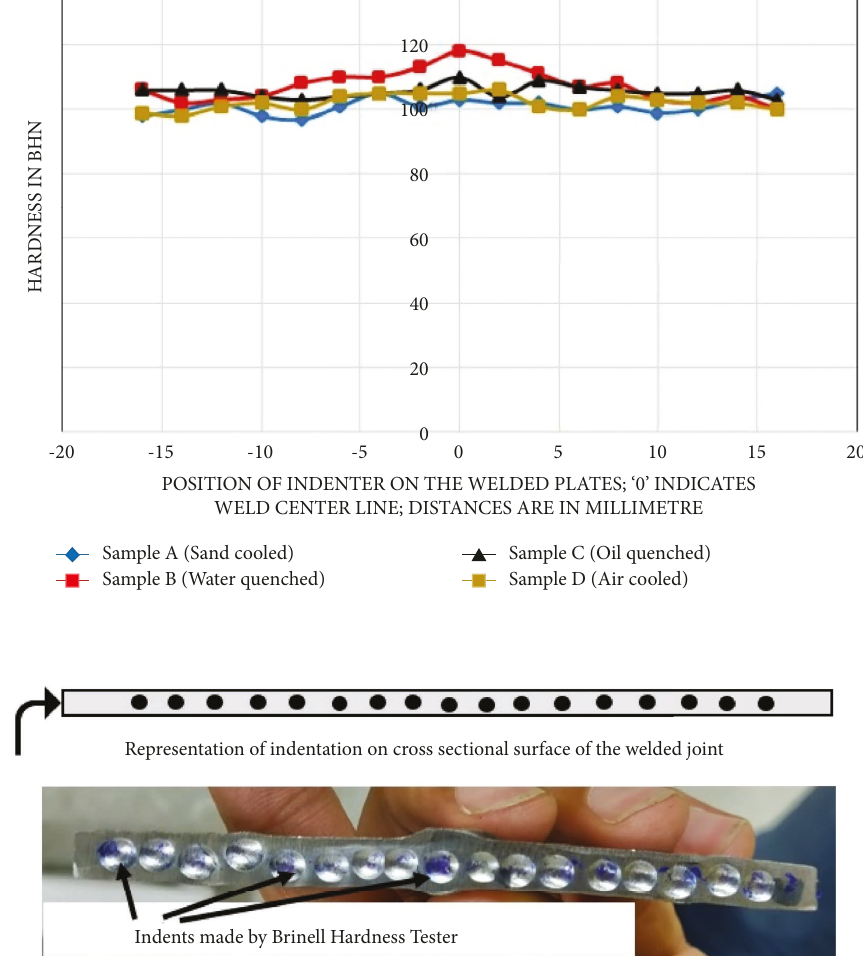
Figure 6: Hardness profile of all the samples; the welded zone possesses high